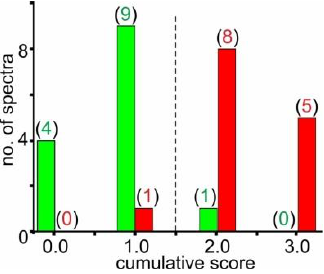
Figure 2. Distribution pattern of cumulative scores with training set “O”. Cumulative score values range between “0.0” and “3.0”. Spectra of training set “O” (first measurement series, MS1, of CTRL I and FGR I serum samples; n = 28) are represented. Green bars represent spectra of CTRL I (patients 101–114) and red bars represent spectra of FGR I (patients 301–314, see Supplemental Table S2). Numbers in parentheses indicate numbers of spectra with the respective cumulative score. The vertical dashed line marks the cumulative score cut-off value which sorts the spectra, which is the respective samples, into either the FGR group (right) or the CTRL group (left).